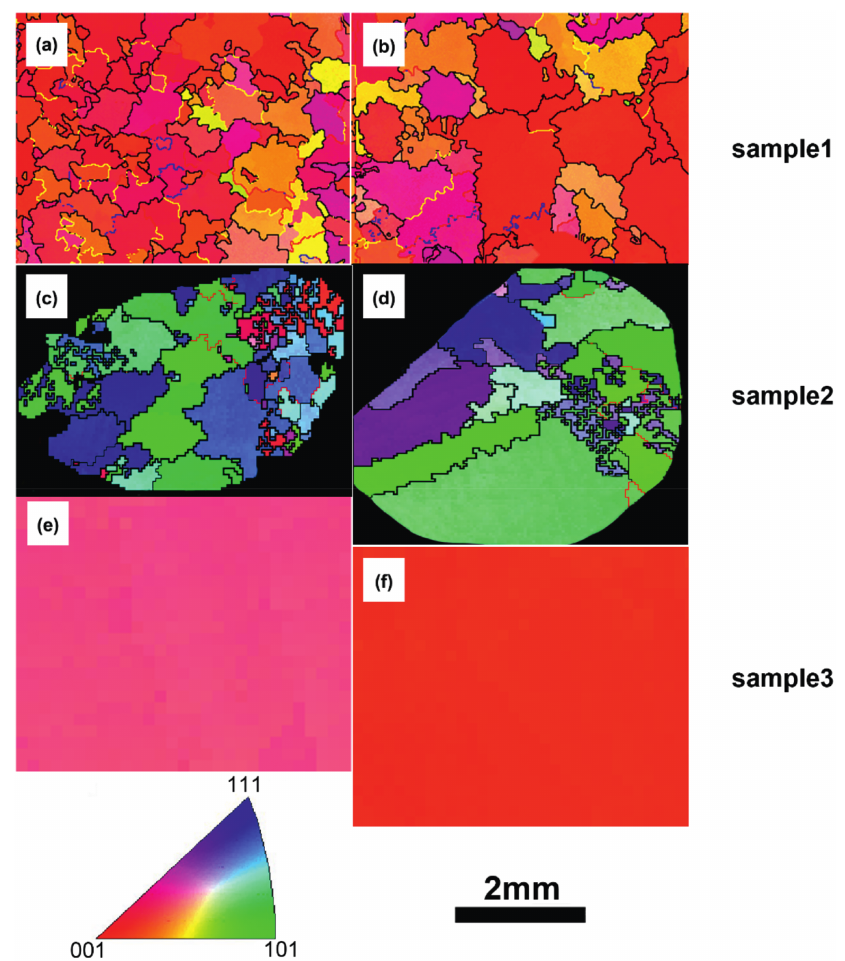
Figure 8: EBSD results on the grain structure of different samples: (a), (c) and (e) the HRS process; (b), (d) and (f) the LMC process.